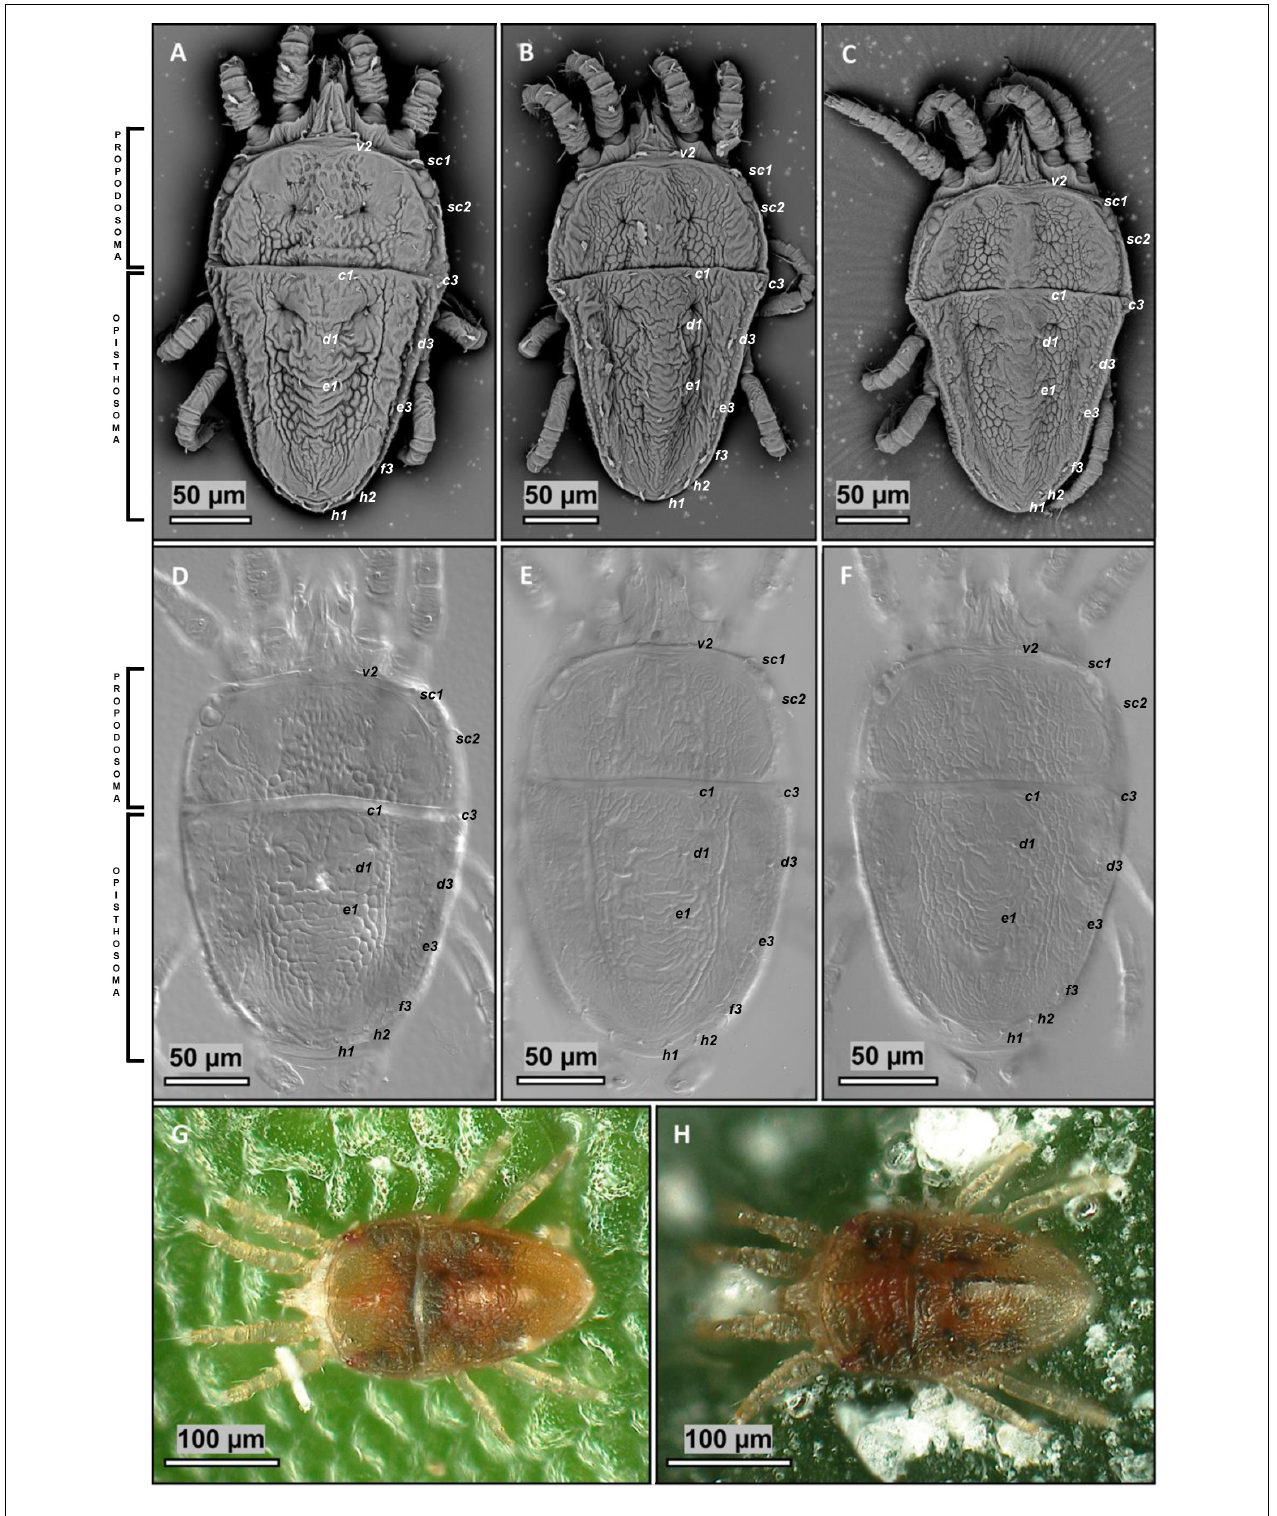
FIGURE 7 | Morphoanatomical identification of Brevipalpus mites. (A,B,H) Brevipalpus papayensis mite collected from Ligustrum spp. plants, samples Crb1 and SPa1, (B,E) Brevipalpus tucuman collected from Ligustrum sinense plant, sample Cdb1. (C , F , G) Brevipalpus obovatus gathered from Solanum violifolium plant, sample Prb1. (A–C) Scanning electron microscopy (SEM) micrographs of the cuticle of the mite dorsum. (D–F) Differential interference contrast (DIC) micrographs of dorsal view of the reticulation pattern. (G,H) Stereoscopic light photographs.